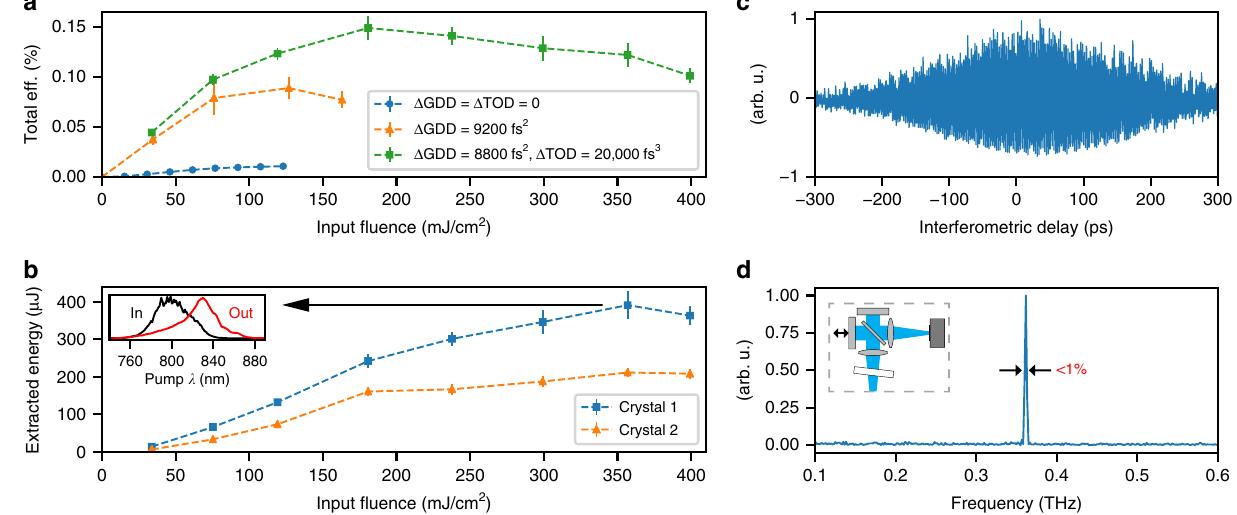
Fig. 5 High THz energy. a Fine tuning the spectral phase increases the fl uence at which the maximum conversion ef fi ciency occurs and reaches 0.15% at 180 mJ/cm 2 for crystal #1. Note, that with simultaneous GDD and TOD correction, the optimum determined Δ GDD is slightly different than the value reported in Fig. 3a. b Using GDD and TOD compensation, an input fl uence of 350 mJ/cm 2 generates individual THz pulse energies up to 458 μ J (392 µ J average) and 232 μ J (212 μ J average) in crystal #1 and #2, respectively. The difference in THz output is attributed to differences in the preparation of the crystal surfaces (see Methods). Signi fi cant red-shift of the driver spectrum is observed for high-energy THz generation indicating a high degree of optical cascading. c Interferometric correlation of the generated THz pulses and its frequency spectrum ( d ), con fi rming the central frequency of 361 GHz and a sub-1% bandwidth. The interferometer (inset) replaces the energy measurement setup, Fig. 2a. Note in c that each data point is averaged over 10 shots. The sampling of the frequency, however, accentuates the visual effect of the shot-to-shot fl uctuations, while indeed the centre frequency is captured with high precision (see Supplementary Note 2). Error bars correspond to the standard deviation of 20 measurements in the case of a and